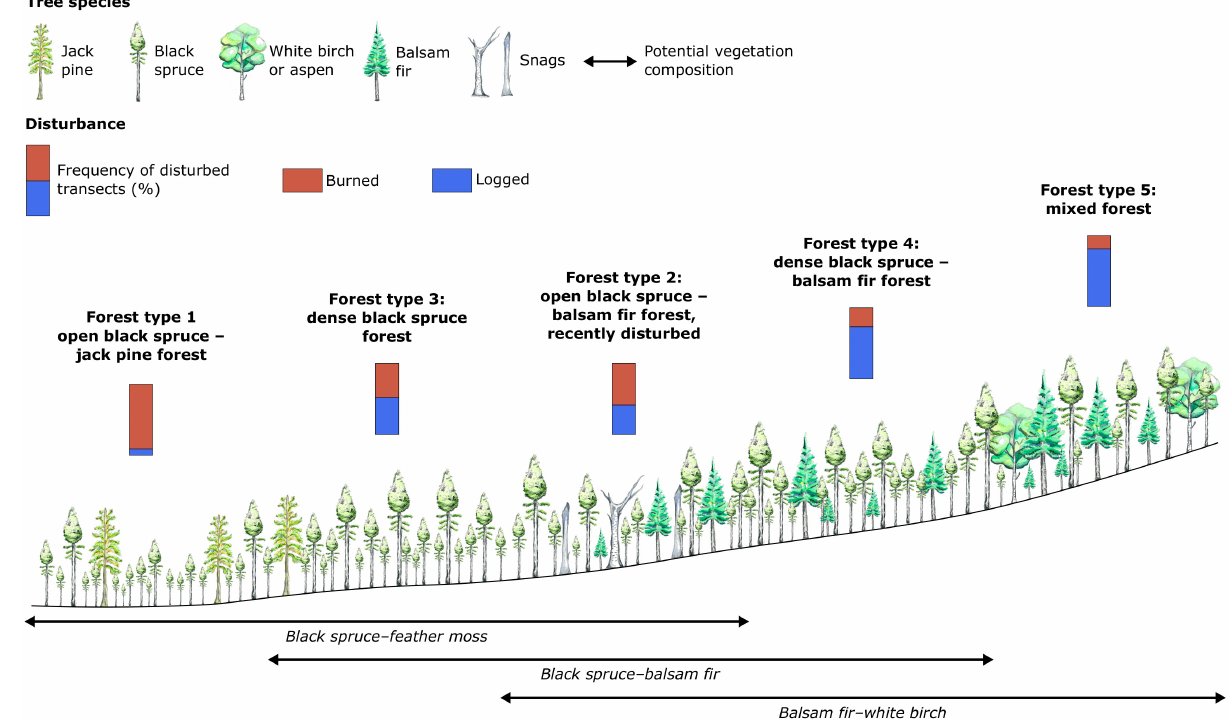
while Forest type 5 contained the less prone, with the other forest types representing different points of the